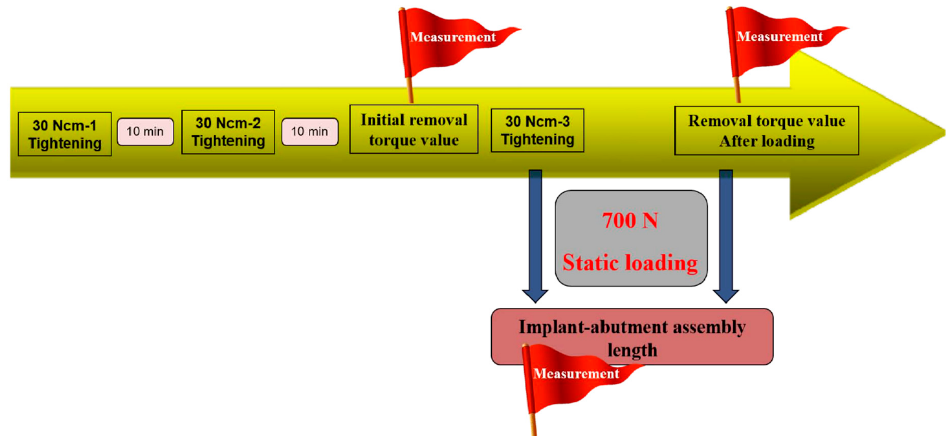
Materials 2020 , 13 , x FOR PEER REVIEW Figure 2. Schematic diagram of experimental design based on protocol sequence. Figure 2. Schematic diagram of experimental design based on protocol sequence.